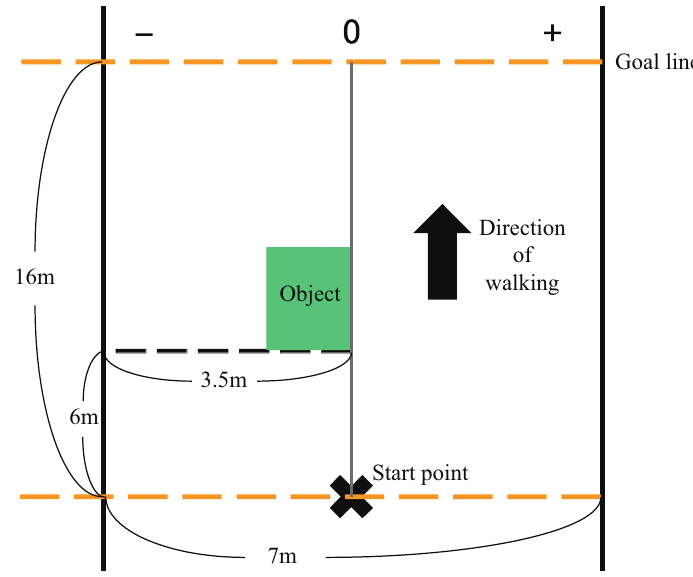
Figure 2. The model of experimental environment when guiding to right. After the test walking, the participant freely walks toward the goal line, which is 16 m from the start point, while seeing virtual objects or the signboard. We measure the distance deviated in the sideways direction from the position straight ahead from the start point at every two meters up to the goal line, with the guidance direction as a positive value. We randomly set the side (left or right) to guide the participant by each object. Also, we randomly set the order of showing the objects. Each participant walks five times total. Each object is displayed so that the front of the object is positioned six meters from the start point. When guiding to the right, we place the right end of the object straight ahead from the start point, as shown in Figure 2. This prevents the difference in object size from affecting the distance deviated in the sideways direction. Figures 1 and 2 show the situation when guiding to the right.